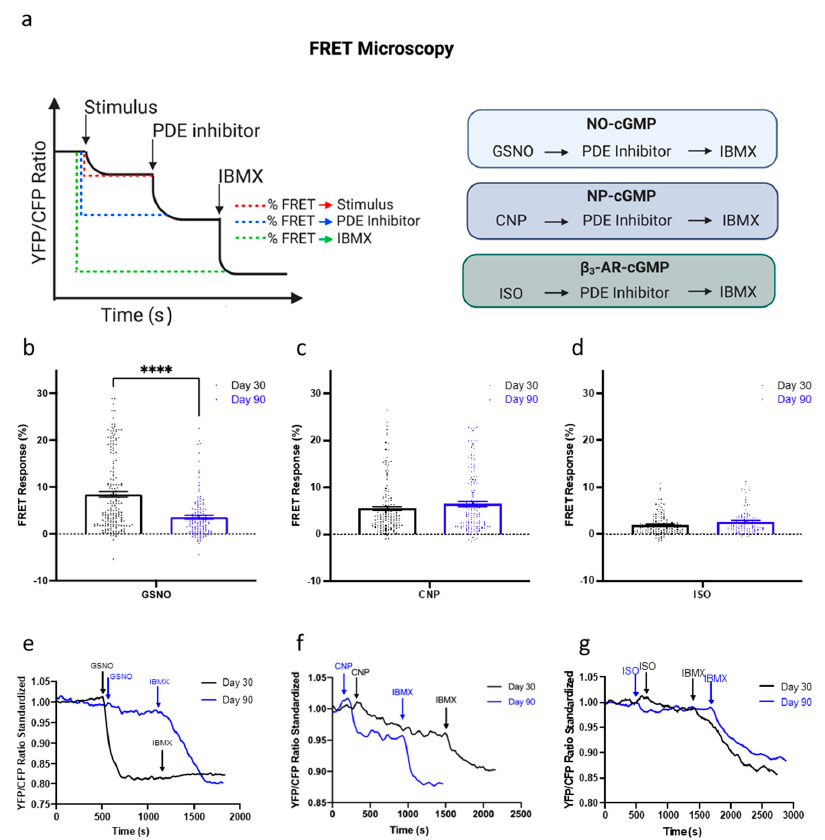
Figure 4. FRET microscopy for the analysis of the cGMP pathways. ( a ) Schematic of FRET micros- copy experimental design. The production of cGMP upon the stimulation of three different pathways; nitic oxide (NO)- ( b , e ), natriuretic peptide receptor (NRP)2 ( c , f ) and β 3 -adrenoreceptor (AR) ( d , g ), via S-Nitrosoglutathione (GSNO), C-type natriuretic peptide (CNP), and Isoproterenol (ISO), respectively, with the corresponding traces shown below. All data is composed of three inde- pendent experimental batches. ****—p < 0.0001